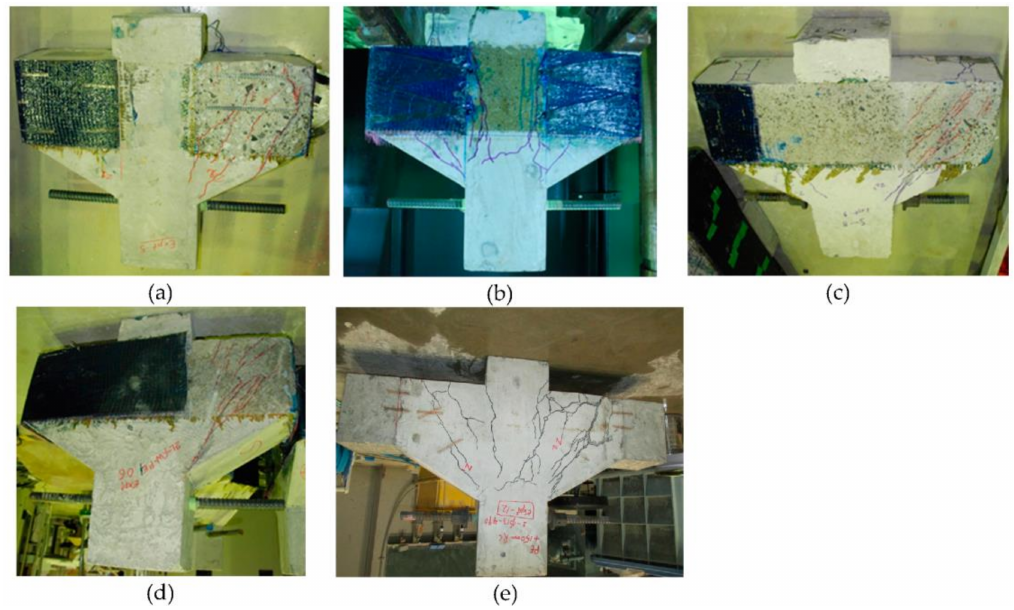
Figure 9. Fracture patterns for corbels of the retrofitting series: ( a ) CFRP-CF-2L; ( b ) CFRP-CF-2L(A); ( c ) CFRP-FW-1L; ( d ) CFRP-FW-2L; ( e )